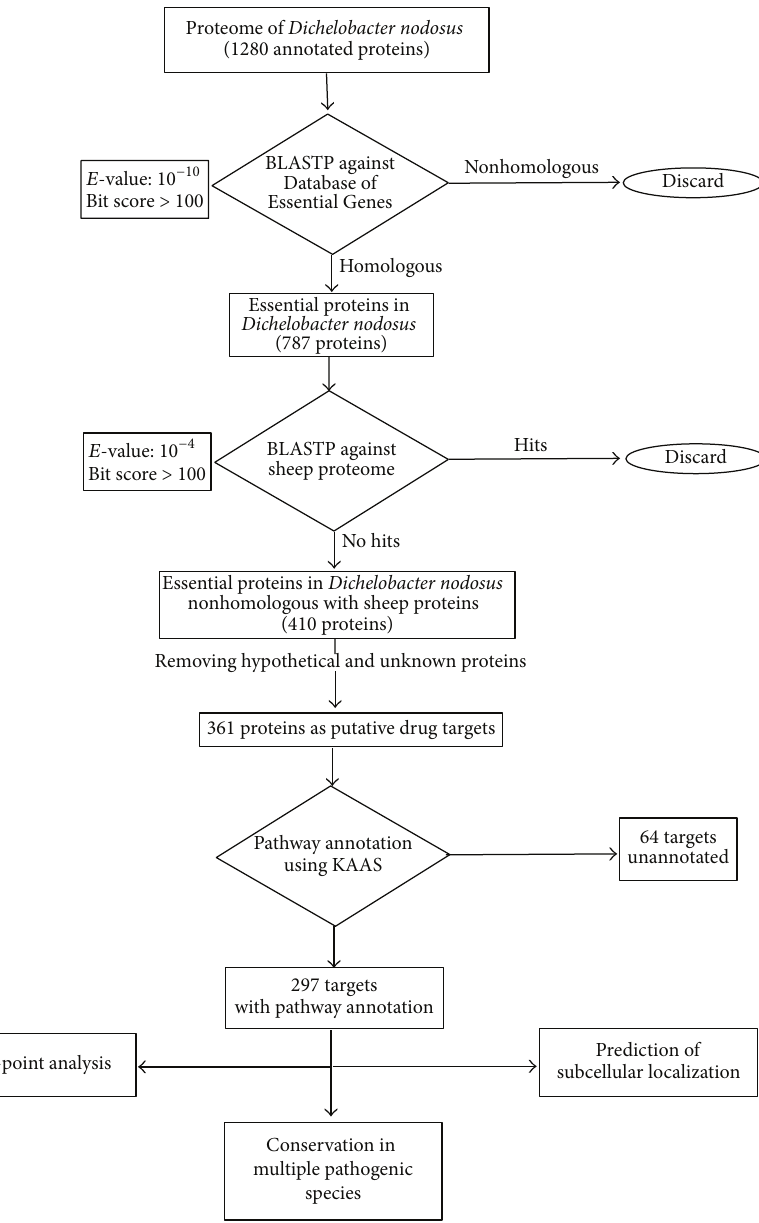
Figure 1: Flowchart depicting the workflow used in this study for identification of putative drug targets and target prioritization against Dichelobacter nodosus